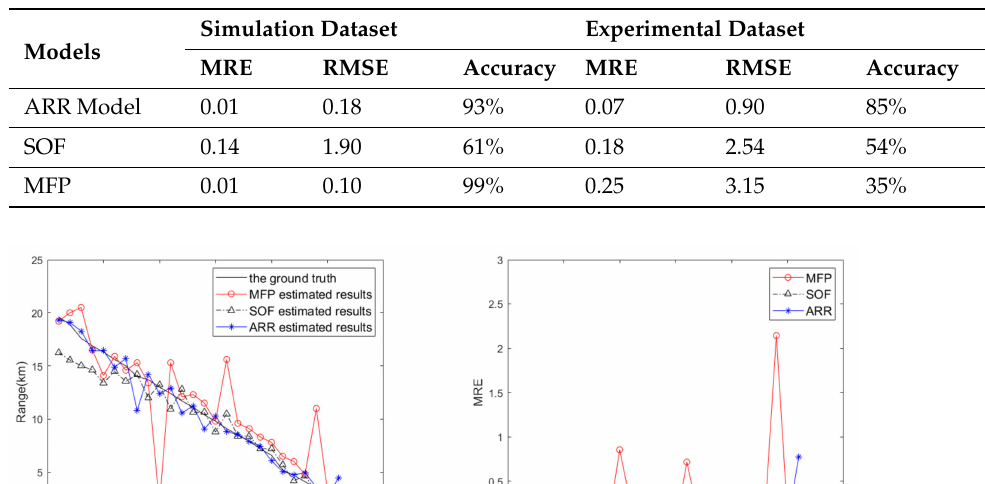
Table 2. Prediction performance of different models.